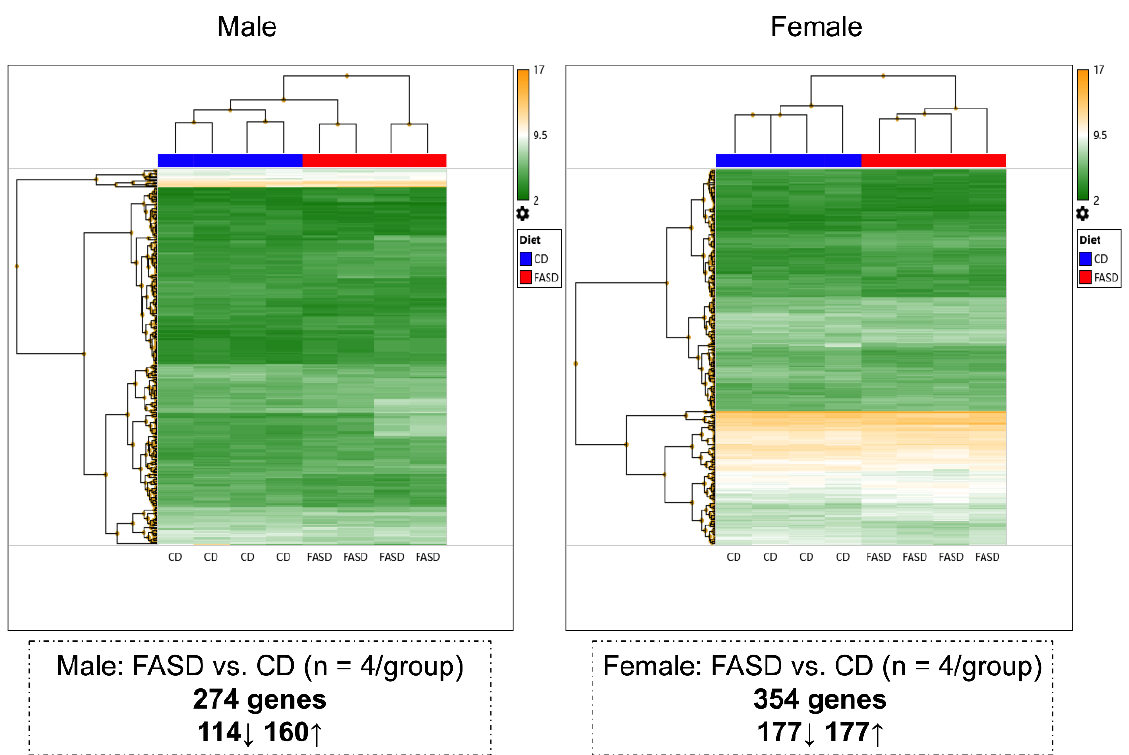
Figure 4. Hierarchical clustering showing different changes in E17.5 cerebral gene expression due to maternal FASD in males and females. A total of 274 genes (114 downregulated, 160 upregulated) were differentially expressed in FASD males compared with CD males, and 354 genes (177 downregulated, 177 upregulated) were differentially expressed in FASD females compared with CD fe- males.